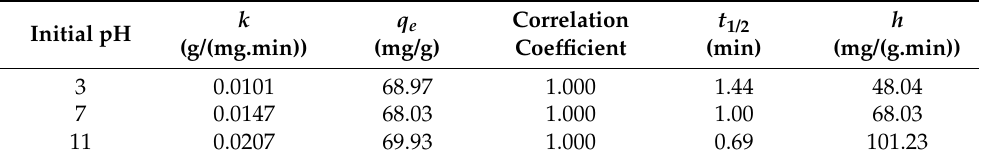
t 1/2 h (min) (mg/(g.min))